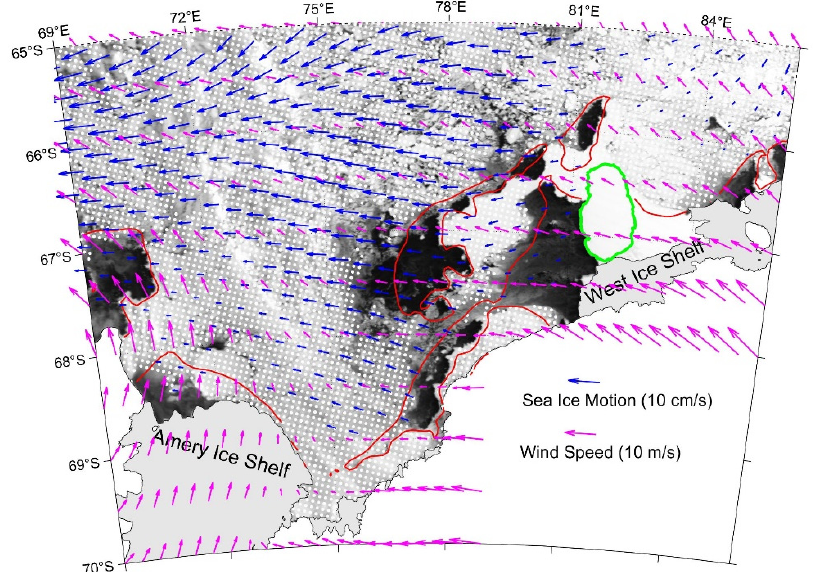
Figure 5. An example of new ice exported from the BaP occupying the area of the DaP, shown in a MODIS image taken on 28 October 2005. The areas with sea ice concentrations >75% on the corresponding day are denoted by white points. The sea ice motion vectors on the same day of the MODIS image and wind vectors one day before are overlain as blue and magenta arrows, respectively. The red lines indicate a POF of 24%, and the green line is the outline of Iceberg D15.